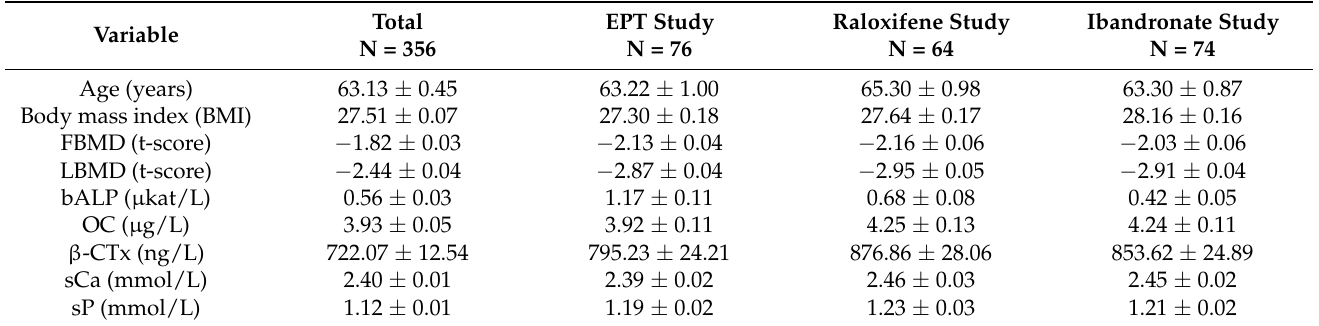
Table 3. General characteristics of the studied groups of